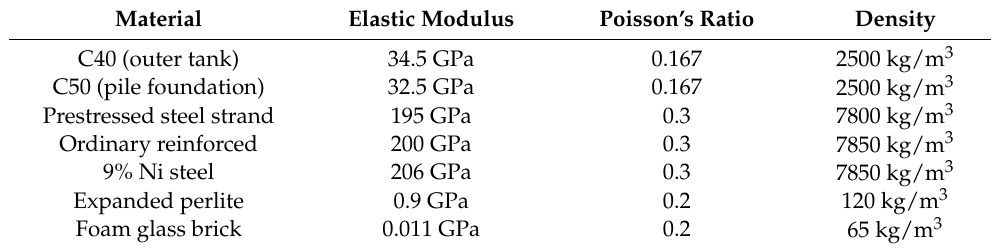
Table 4. Material parameters of LNG storage tank.